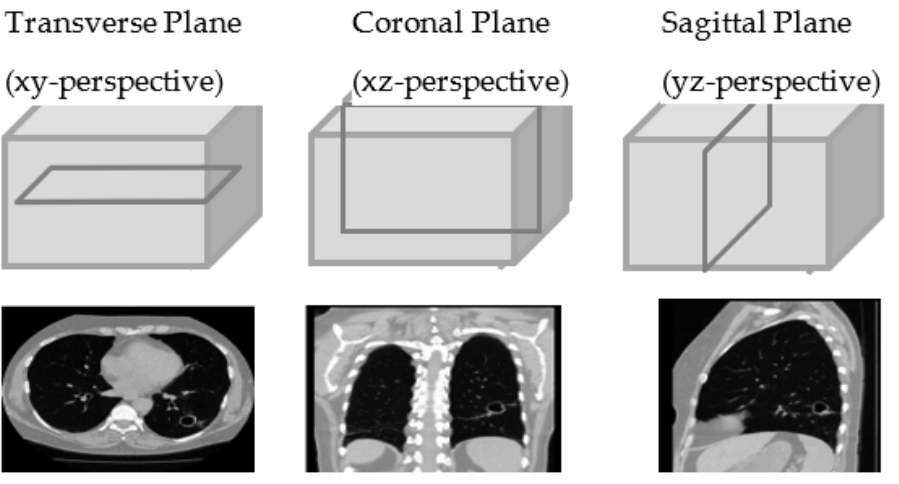
Figure 2. Slices from three different perspectives.